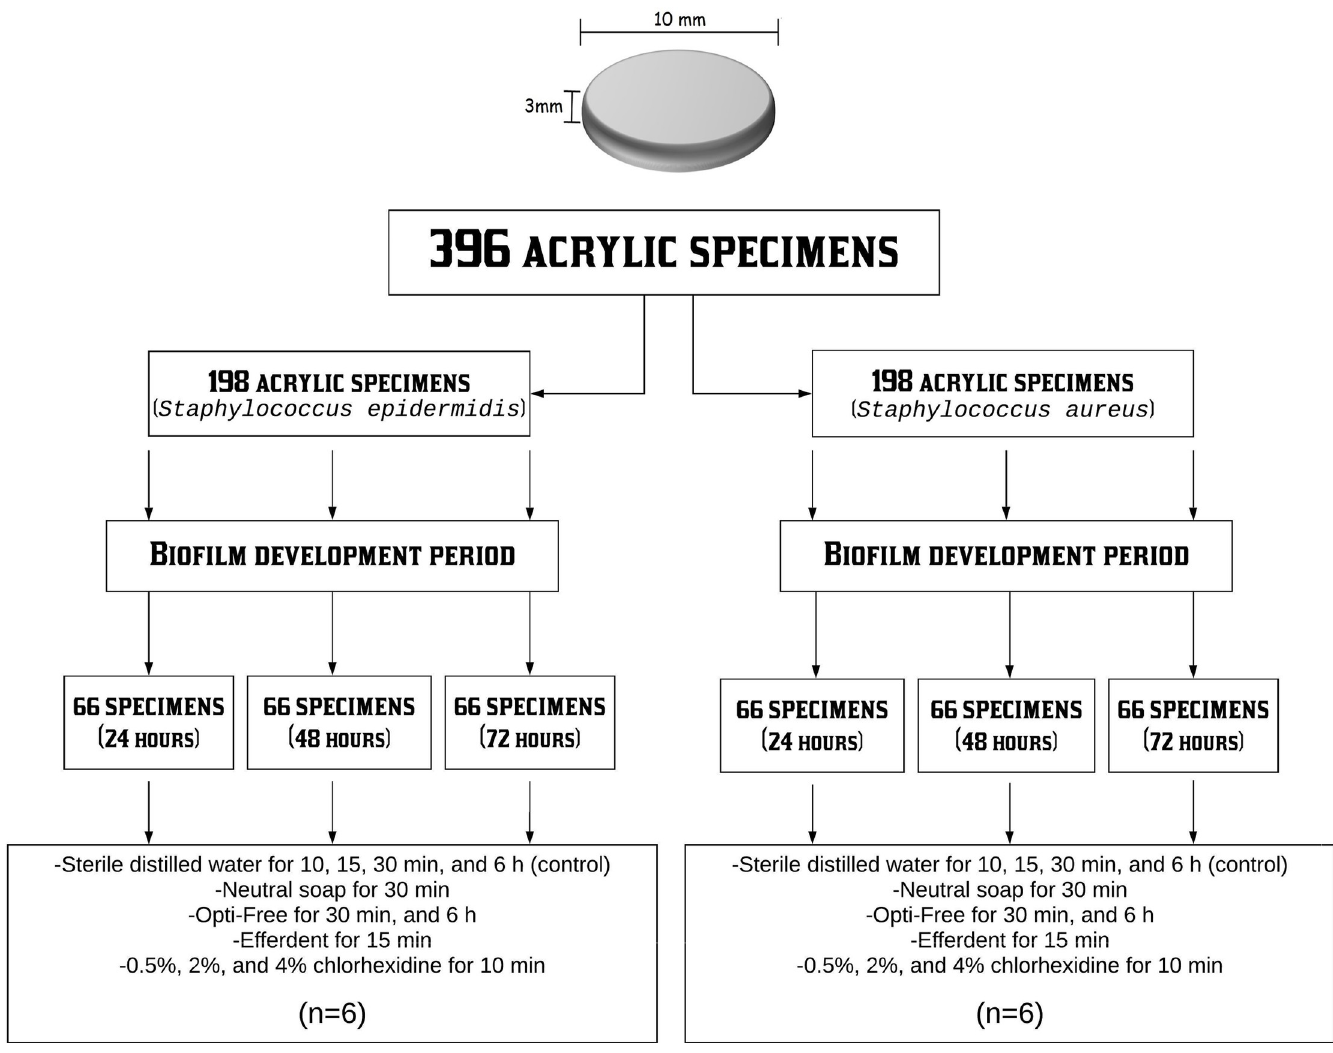
Fig 1. Distribution of